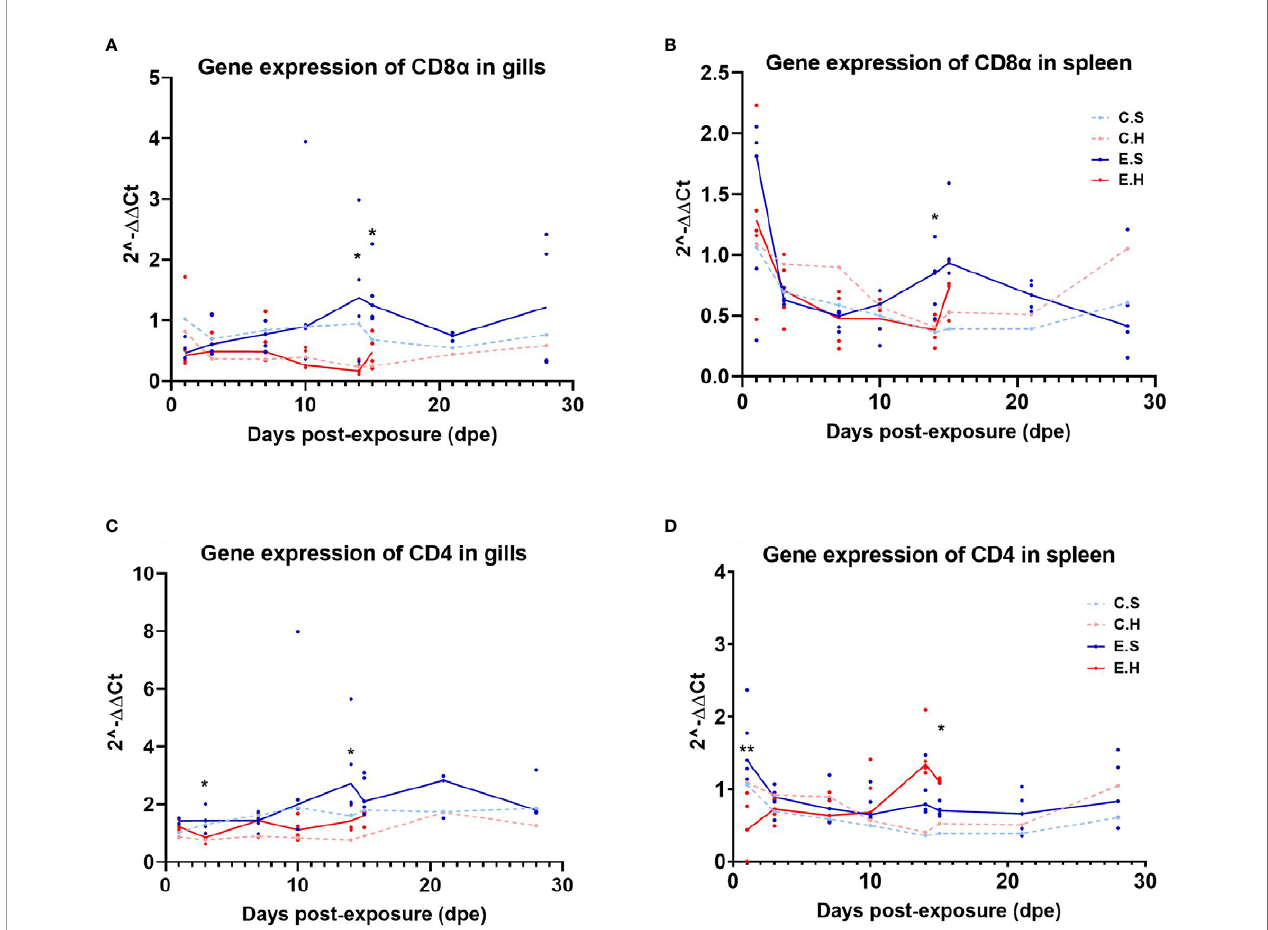
FIGURE 4 | Gene expression of CD8 a in gills (A) and spleen (B) and gene expression of CD4 in gills (C) and spleen (D) from the entire SGPV infection trial. Both median (line) and individual data (dots) are shown from the SGPV-exposed groups. Control groups are only shown with median value. Signi fi cant differences are calculated between the two infected groups, E.S and E.H. *P< 0.05, **P< 0.01. C.S, Uninfected control sham injected group; C.H, Uninfected control hydrocortisone-injected group; E.S, SGPV-exposed sham injected group; E.H, SGPV-exposed hydrocortisone-injected